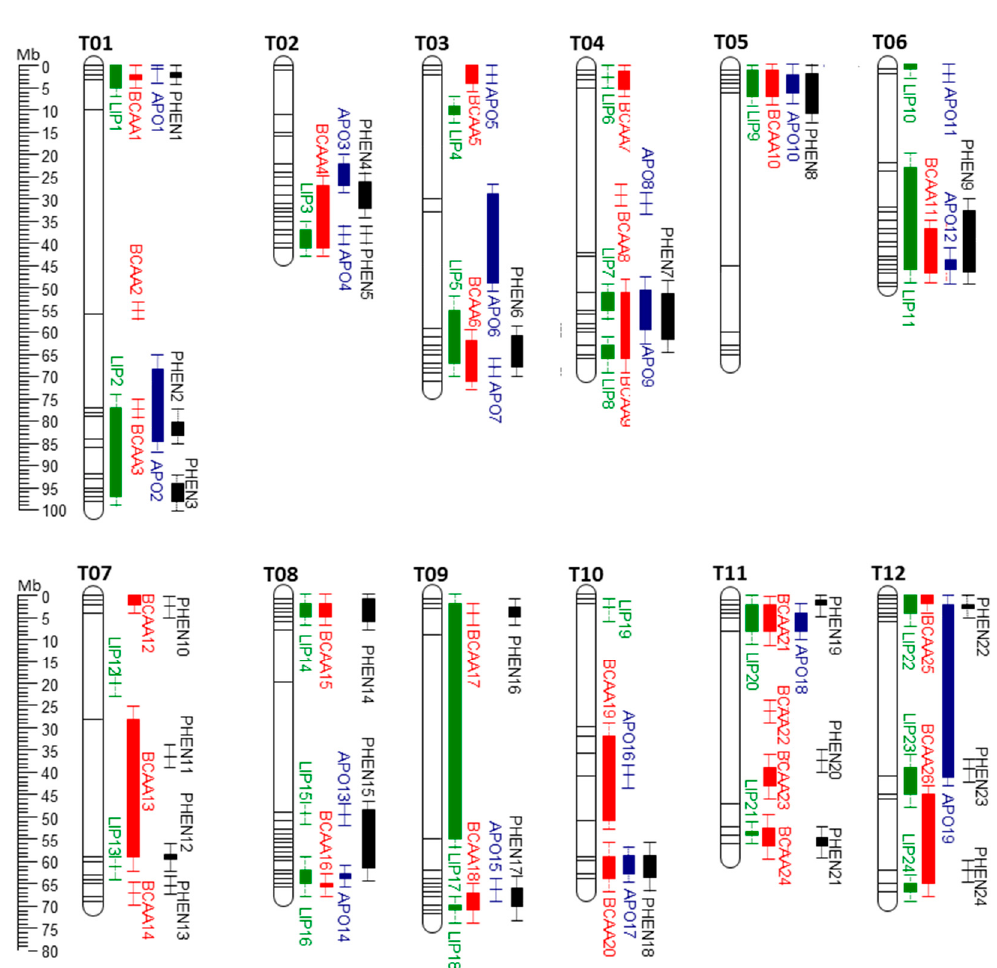
Figure 1. VOCs QGRs chromosome map (T01–T12) obtained from the reported literature. Green: Lipid VOCs QGRs; Red: BCAA VOCs’ QGRs; Blue: Apocarotenoid VOCs QGRs; Black: phenolic VOCs QGRs. The estimated confidence interval (± 2.5 Mb), has been reported in the figure.